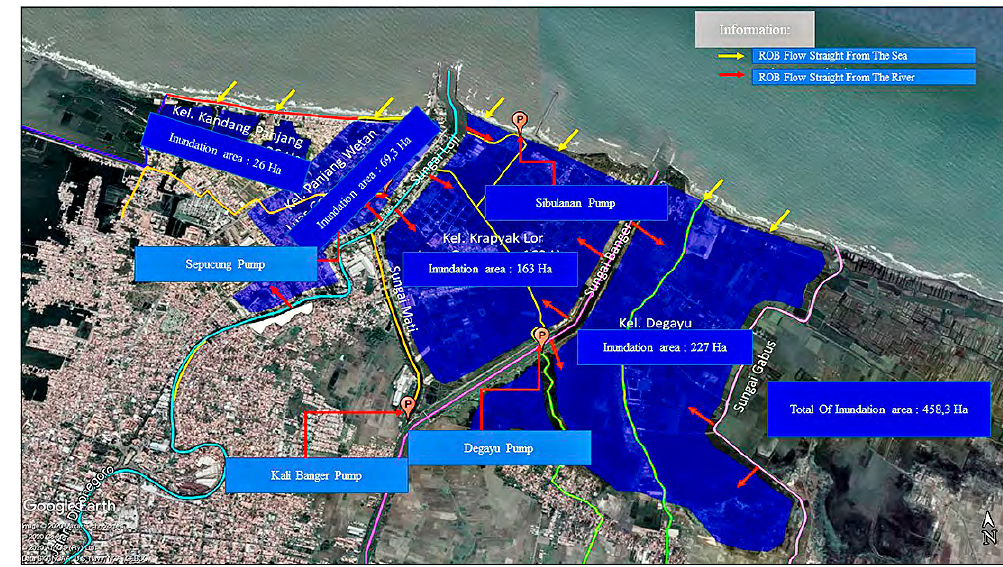
Figure 4. Inundation Area and Existing Pump System for Tidal